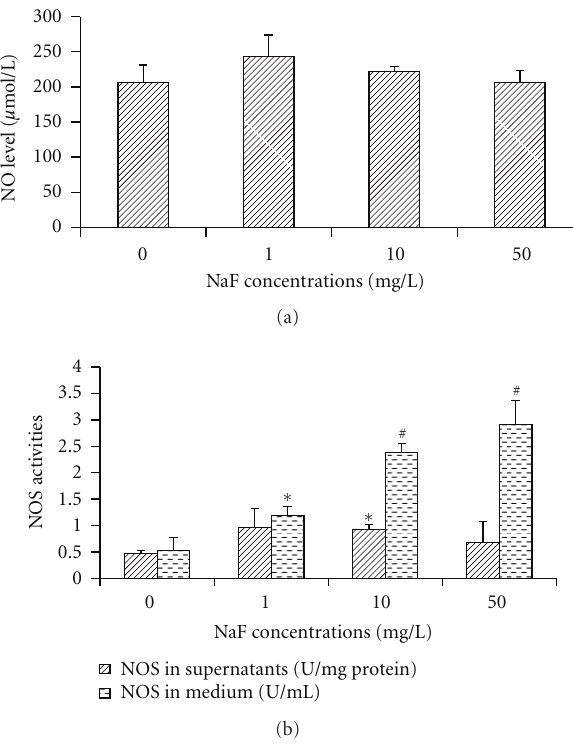
Figure 4: E ff ects of fluoride on NO production (a), and NOS activities (b) in microglial BV-2 cells. After the cells were treated with various concentrations of NaF (1, 10, and 50 mg/L) for 24 h, NO release in culture medium and NOS activities in supernatants and medium were measured using commercial test kits. Bars were presented as mean ± SD. ∗ P < 0 . 05 and # P < 0 . 01 compared to the control